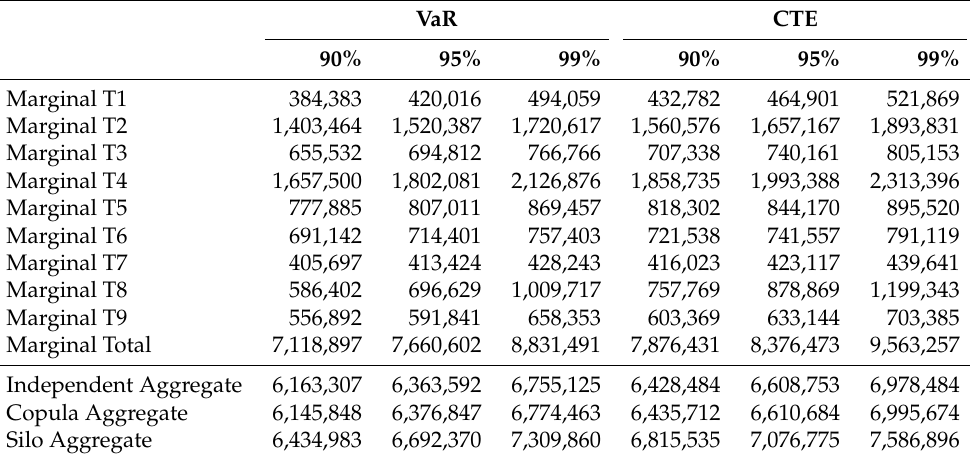
Table 8. Estimated risk margins for the unpaid claims.